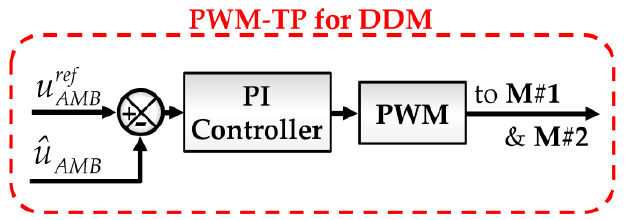
Figure 6. Schematic diagram for PWM-TP (pulse width modulation-tuning processors) under DDM (digital driving mode).